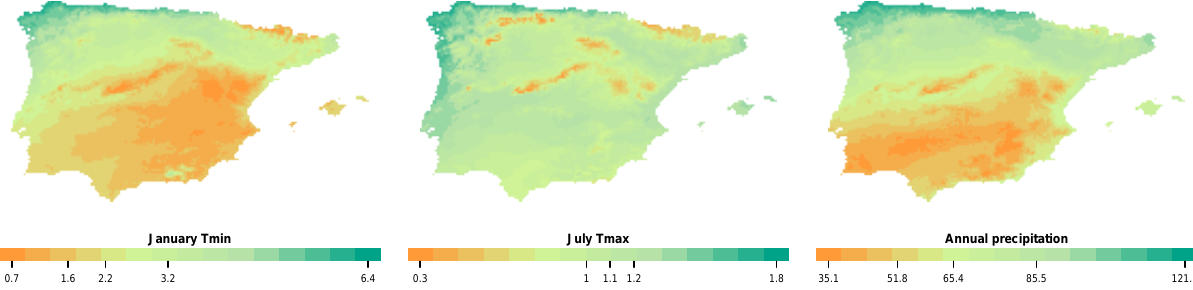
Figure 6. Average differences between millennia for each of the climate variables. Calculation of the differences are computed between a given age and the previous one. Isolines in each map indicate the average value of